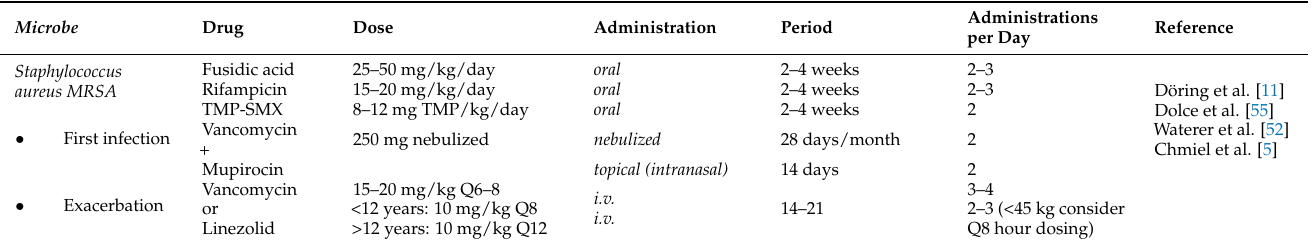
Table 3. Recommended antibiotics for Staphylococcus aureus MRSA infection in CF